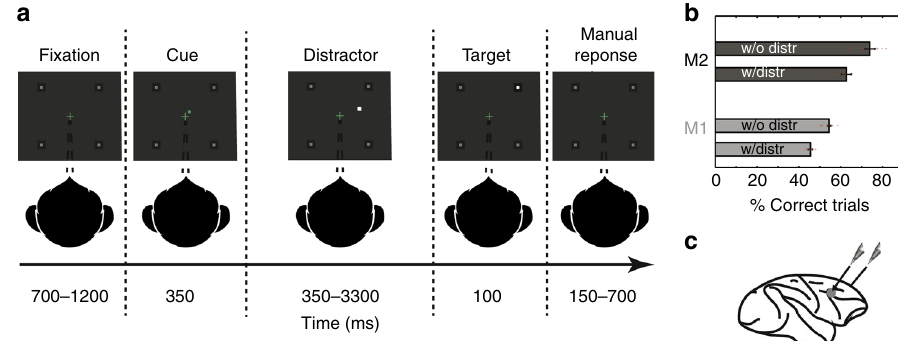
Fig. 1 Task design and associated behavioral performance. a 100% validity cued target-detection task with distractors. To initiate a trial, monkeys had to hold a bar and fi xate a central cross on the screen. Monkeys received a liquid reward for releasing the bar 150 – 750 ms after target presentation. Target location was indicated by a cue (green square, second screen). Monkeys had to ignore any uncued event. b Behavioral performance of monkeys M1 and M2 at detecting the target in the presence (w/) or absence (w/o) of a distractor (median % correct + / − median absolute deviation, dots correspond to individual session data points). c Recording sites. On each session, 24-contact recording probes were placed in each